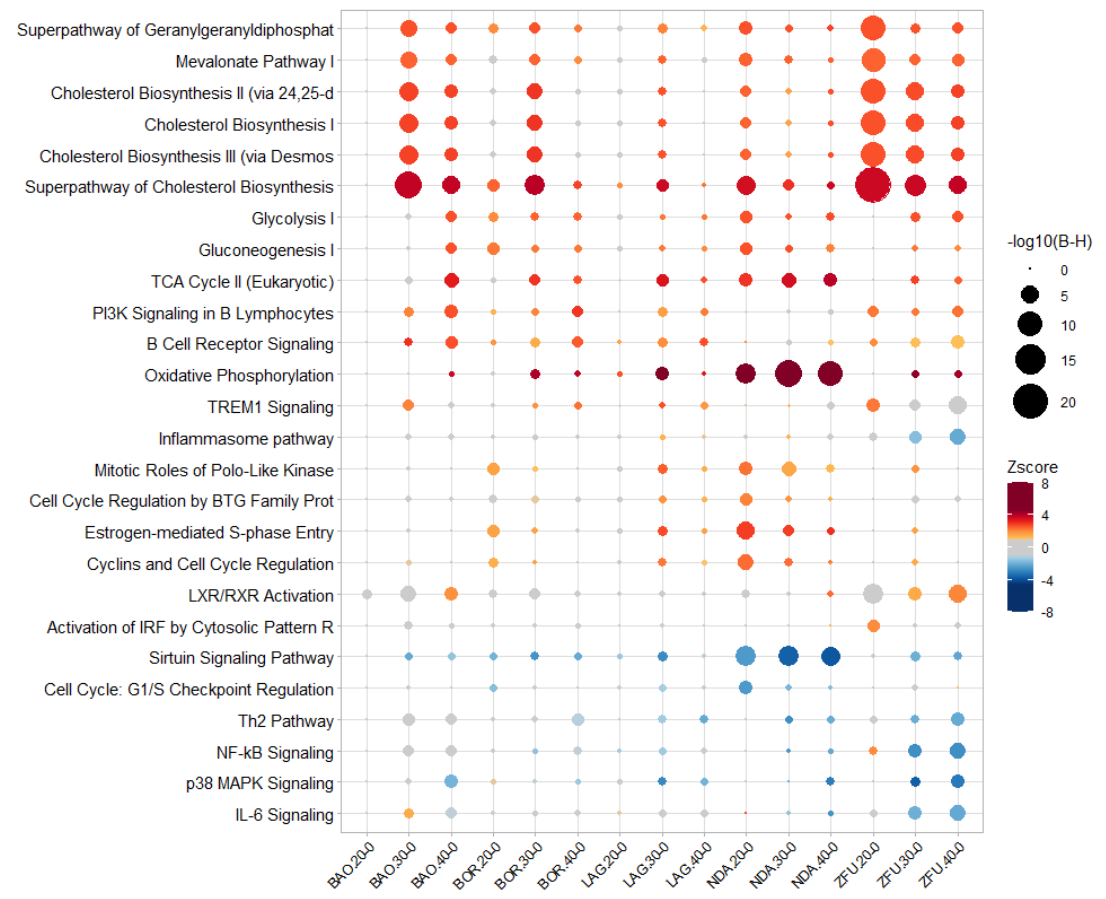
Figure 7 - Plot of 26 significantly enriched canonical pathways inferred as activated or inhibited in function of the within-breed contrasts. The 15 within-breeds contrasts are shown on the abscissa and the significantly enriched diseases and functions on the ordinate. The size of the circles is inversely proportional to the B-H corrected p -value of the canonical pathways in the aforementioned contrast. The color gradient of the circle corresponds to the Z-score range, i.e. warm color gradient for positive Z-score>1, cold color gradient for negative Z-score<-1, and gray color gradient for Z-scores ranging between -1 and